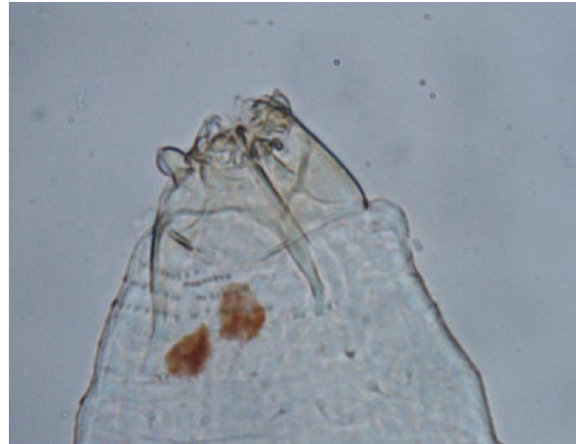
Figure 8: The first instar does not have long mycangial bristles as reportedin Lasiopteraarundinis .Notethattheheadcapsuleisnearly as wide as the prothorax.